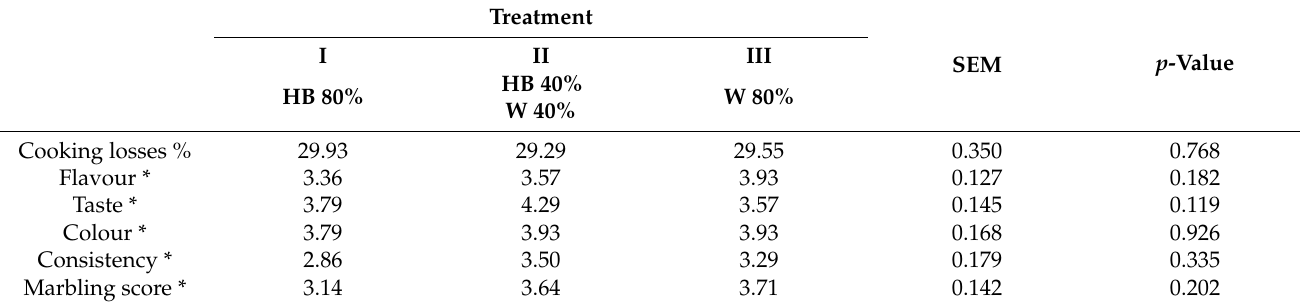
Table 4. Cooking losses, meatiness, and sensory desirability of pork meat after heat